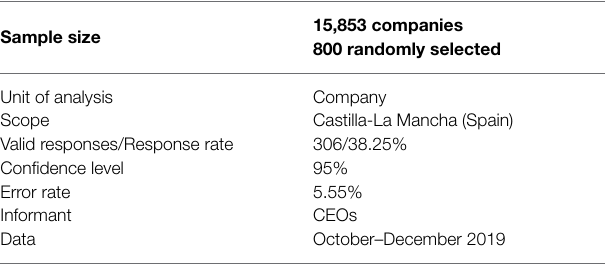
TABLE 1 | Research technical data. Sample size